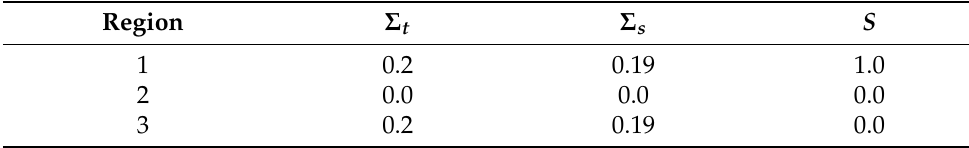
Table 1. Material properties of the Maynard